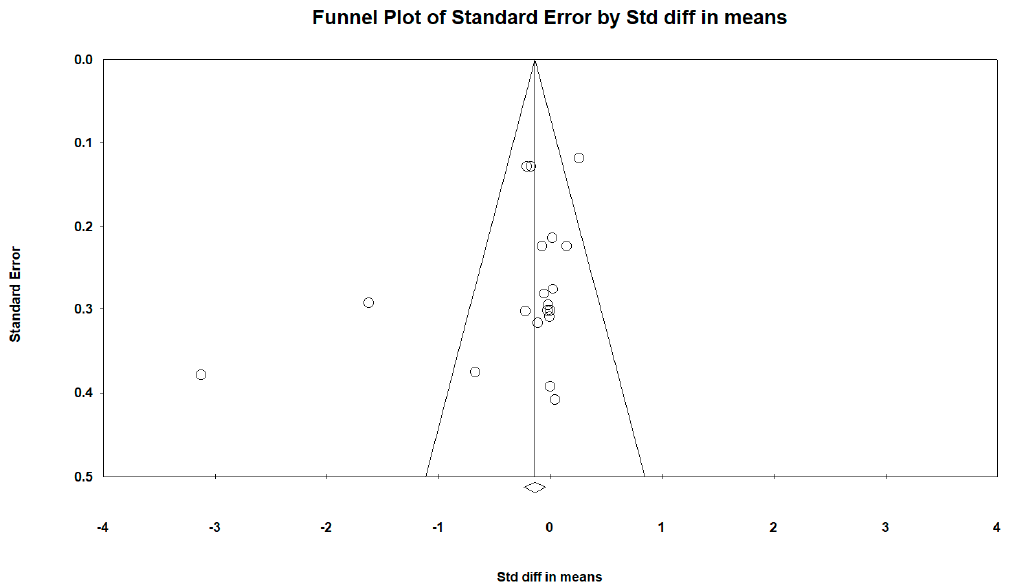
Figure 14. Funnel diagram or “funnel plot” of the standard error (Y axis) by the SMD (X axis). Pre-post intra-group difference in BMI in the group intervened with active video games (all determinations and all follow-ups).